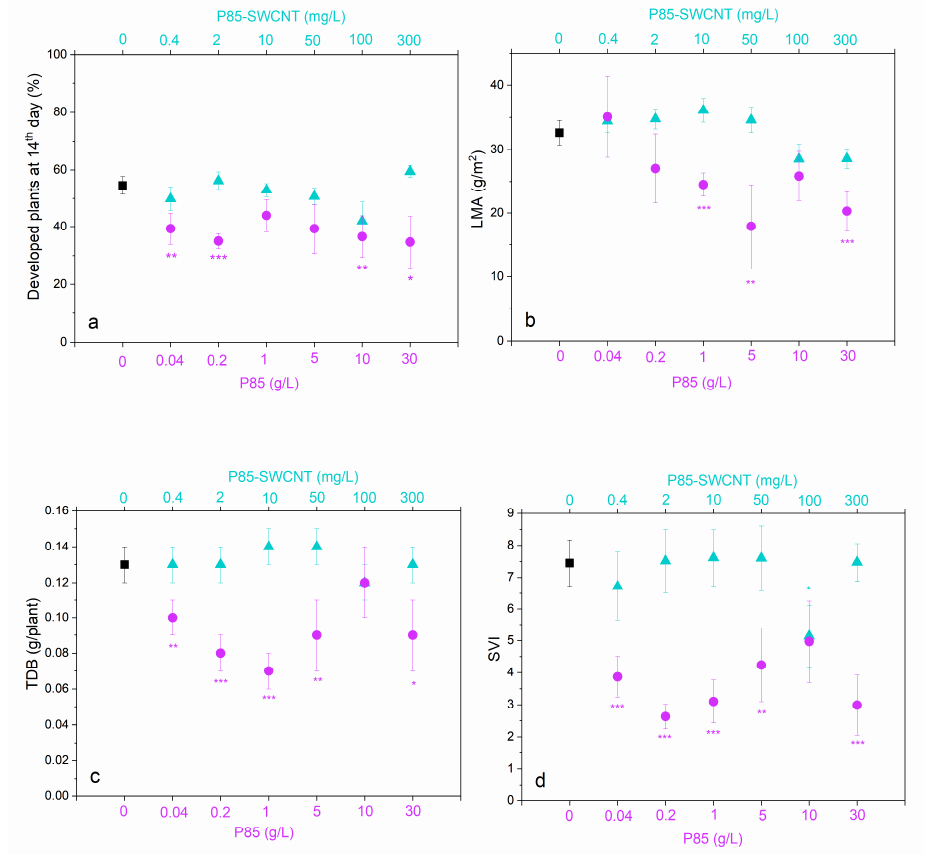
Figure 2. Plant growth parameters determined for hydro-, P85-SWCNT-, and P85- primed seeds at the 14th day after seeds sowing. Percentage developed plants ( a ), leaf dry mass per unit leaf area (LMA, ( b )), total dry biomass (TDB, ( c )) and survival index (SVI, ( d )). Mean ± SE. Statistically significant differences from the control sample at p < 0.1 (*), p < 0.05 (**), p < 0.01 (***) according to Student’s t -test are indicated with asterisk in the respective colors (violet for P85 and cyan for P85-SWCNT treatments). Table 3. Anatomical characteristics of Pisum sativum leaves developed from hydro-primed con- trol seeds and seeds primed in dispersions with different concentrations of P85-SWCNT and P85. Mean ± SE. Statistically significant differences from the control sample at p < 0.05 (**), p < 0.01 (***) according to Student’s t -test are